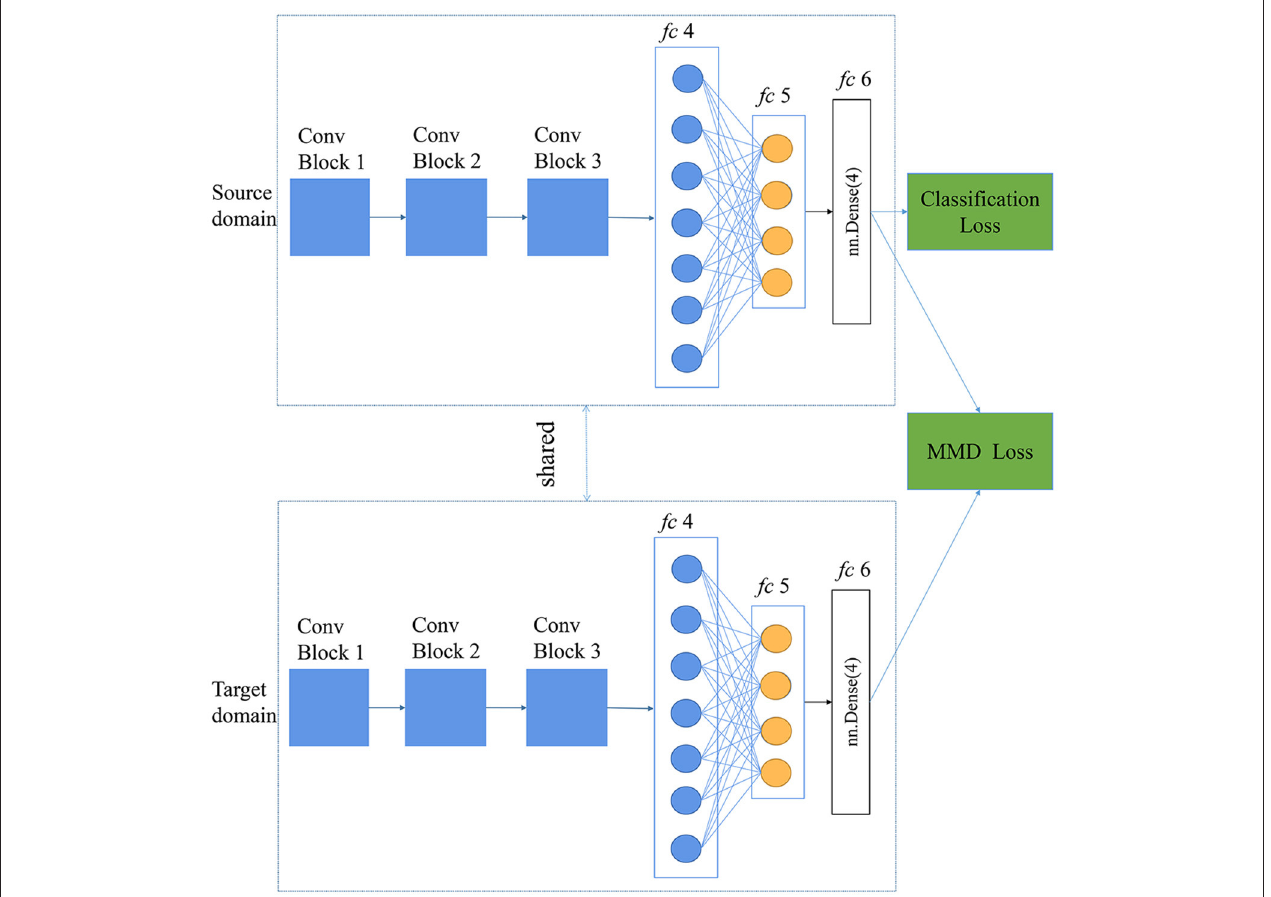
FIGURE 4 | Deep Domain Confusion (DDC) architecture based on a self-designed